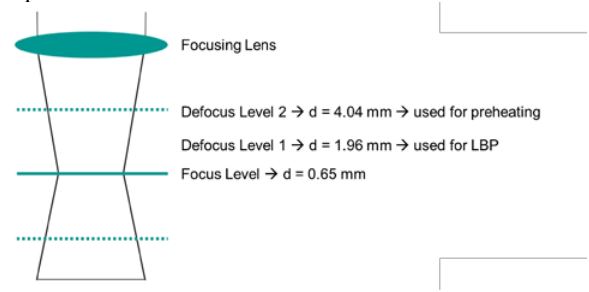
Fig. 2. Defocusing setup of the CO 2 laser beam for preheating